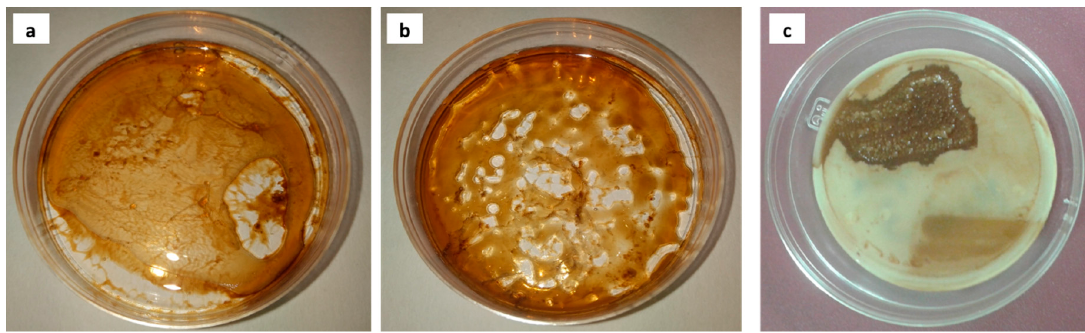
Figure 6. Identification of unstable IL and lignin systems: ( a ) 1.4 g Aliquat + 1.6 g lignosulphonate solution (40 g/L). ( b ) 1.6 g CYPHOS 108 + 1.9 g lignosulphonate solution (40 g/L). ( c ) CYPHOS 108 in